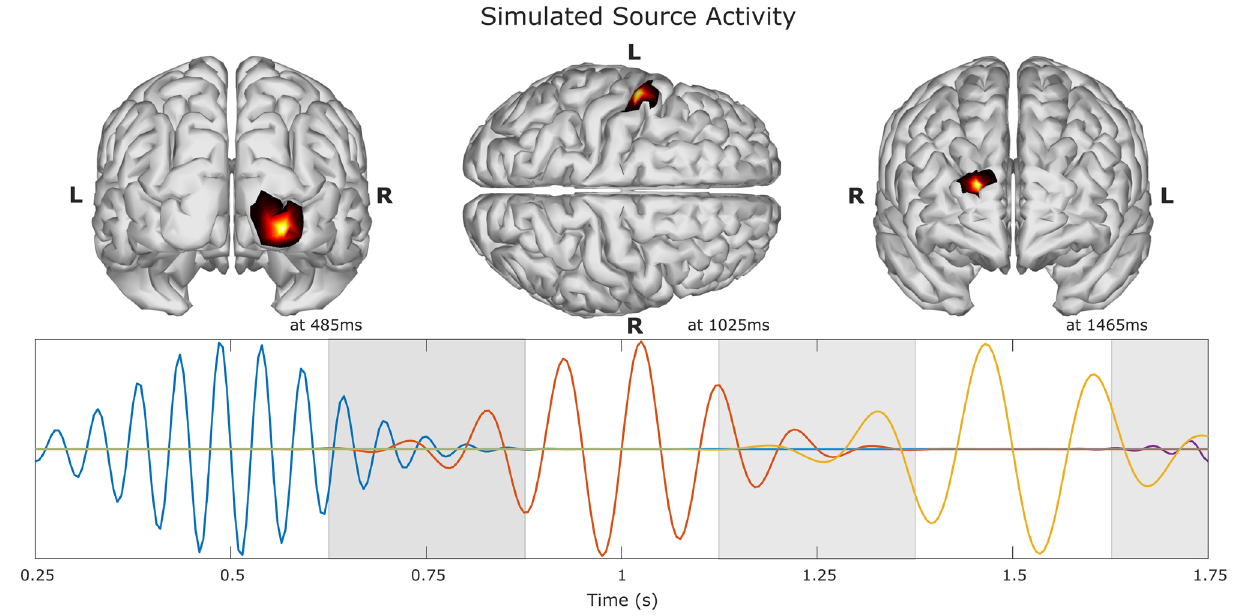
Figure 2. Example of simulated source activity. Source s 1 time course is depicted in color blue, source s 2 in orange, source s 3 in yellow, and the remaining activity from s 4 in purple. The locations of the first three sources are depicted on top, where the time was chosen where the maximum amplitude value for each source took place. The light gray areas depict the time sections where there are temporal mixing between